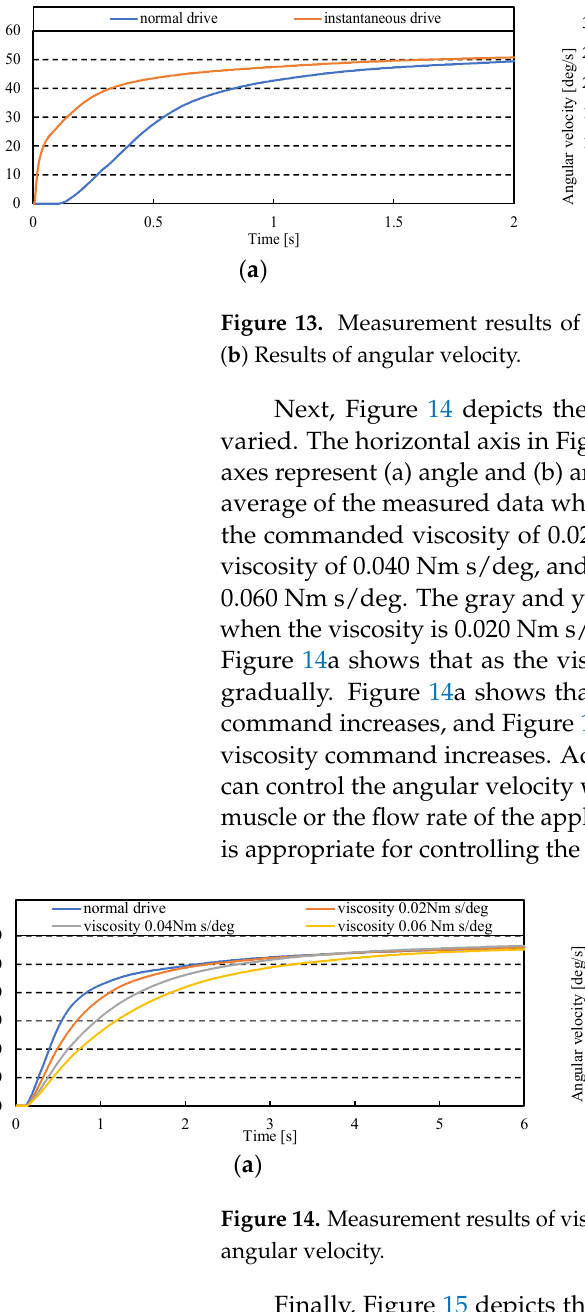
Figure 14. Measurement results of viscous drive and normal drive. ( a ) Results of angle. ( b ) Results of angular velocity.